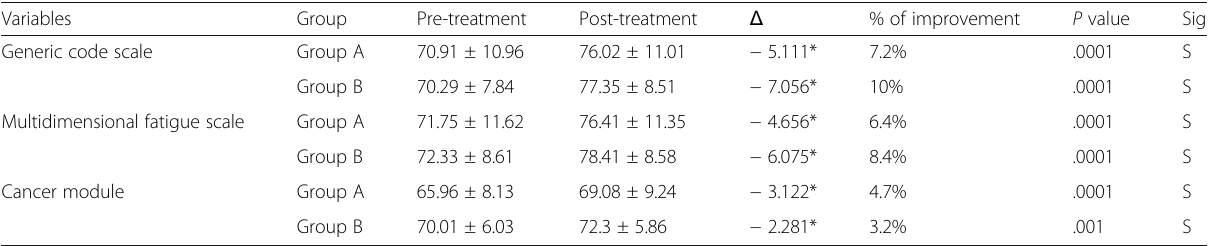
Table 8 Comparison of the mean values of quality of life before and after treatment for both groups A and B Variables Group Pre-treatment Post-treatment